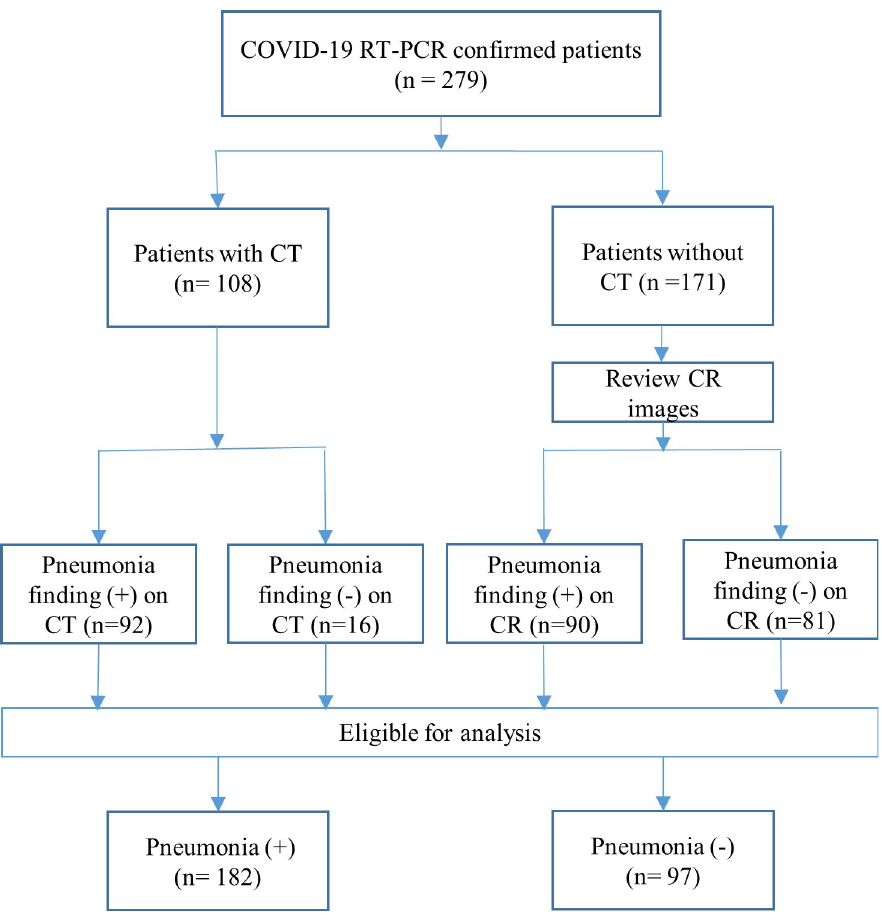
Fig 1. Flow chart of reference standard for COVID-19 with pneumonia and COVID-19 without pneumonia. CR, chest radiography; CT, computed tomography; RT-PCR, reverse transcription polymerase chain reaction.